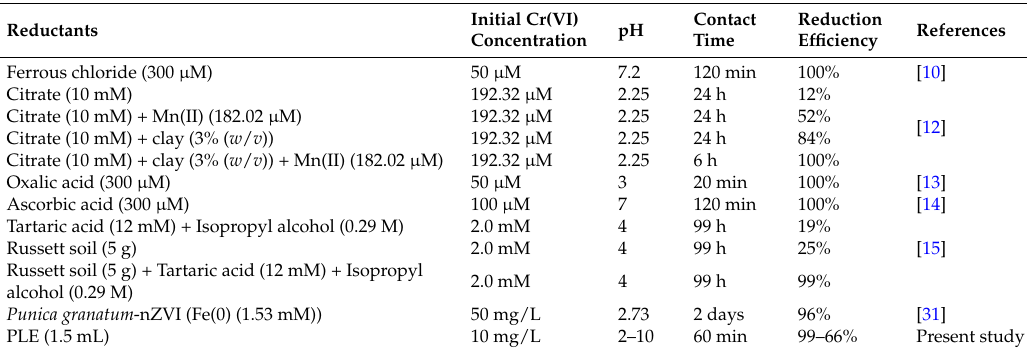
Table 1. Comparison of results using various reductants.